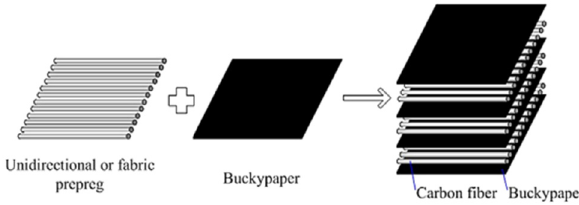
Figure 12: Stacking schematic of hybridization of BP and CF to manufacture reinforced material [ 65 ]